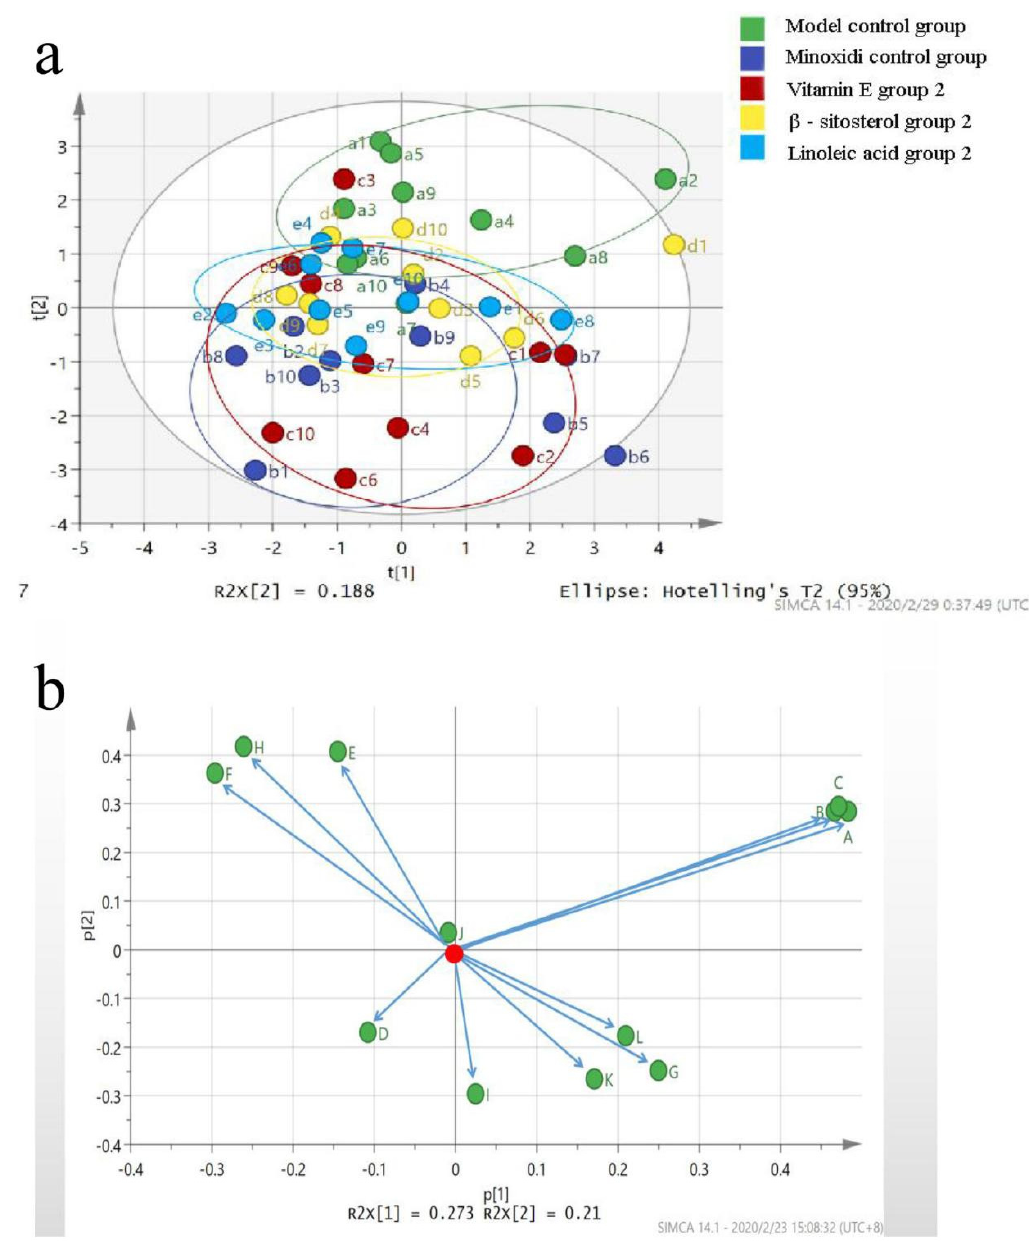
Figure 16. ( a ) PCA-X score diagram. ( b ): Contribution rates of indicators (a total number of hair follicles; B: number of primary hair follicles; C: number of secondary hair follicles; D: dermal thickness; E: mRNA expression of β -catenin; F: mRNA expression of GSK-3 β ; G: Cyclin D 1 mRNA expression; H: mRNA expression of LEF 1; I: protein expression of β -catenin; J: protein expression of GSK-3 β ; K: protein expression of Cyclin D 1; L: protein expression of LEF 1).